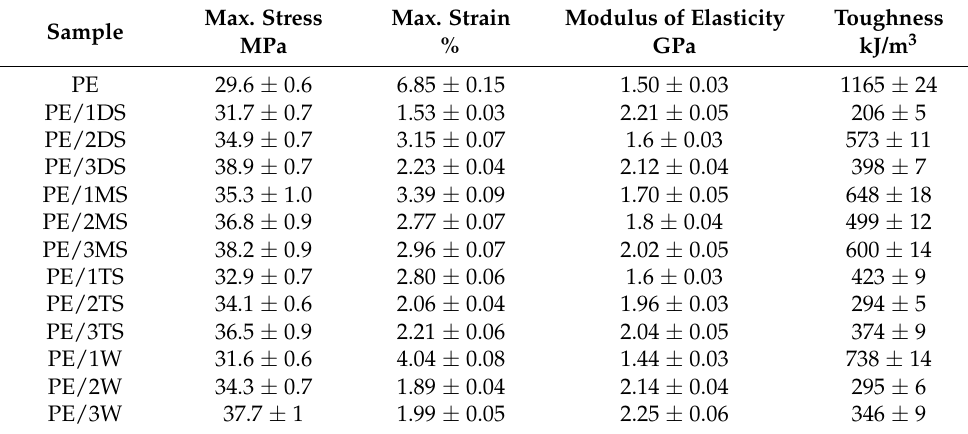
Table 4. Tensile properties of plain epoxy and silicate reinforced